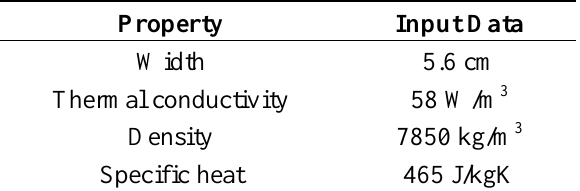
Table 6. The iron frame physical properties applied to the